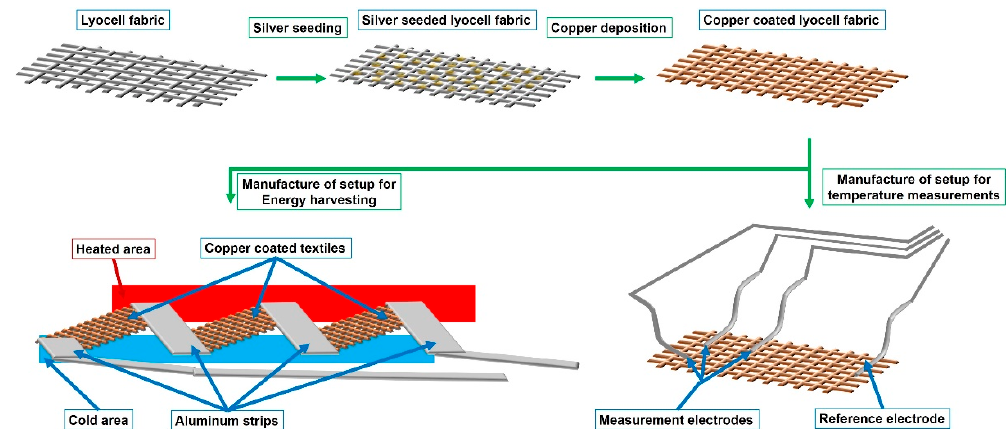
Figure 1. Manufacture of textile-based thermocouples usable for temperature measurements and energy harvesting, made from copper-coated lyocell fabrics.